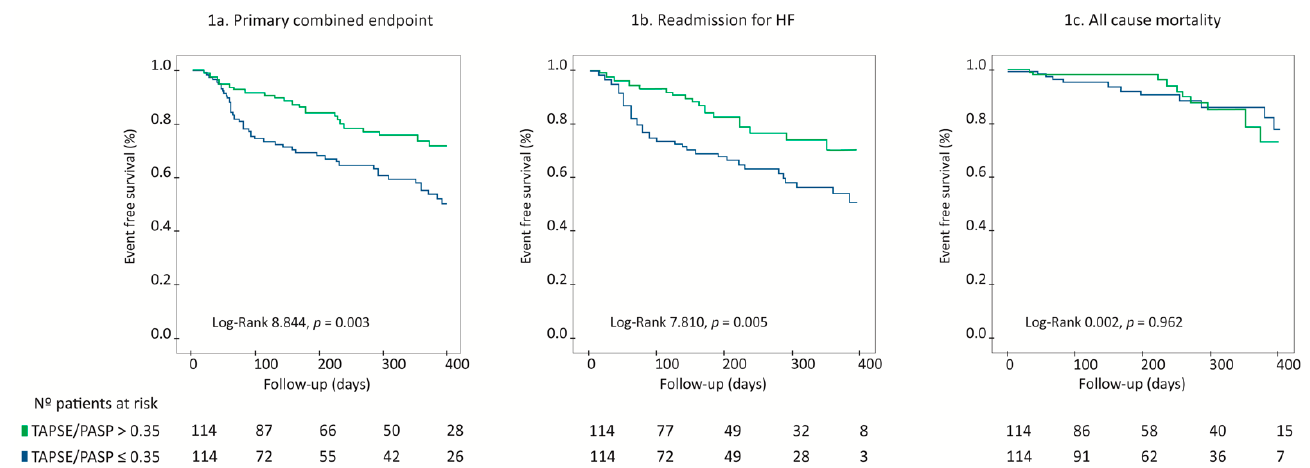
Figure 1. Survival analysis according to TAPSE/PASP ratio as shown by Kaplan–Meier curves. TAPSE/PASP ratio ≤ 0.35 is associated with higher rates of the primary combined endpoint ( a ), higher HF readmissions rates ( b ) without differences in all-cause mortality rates ( c ). TAPSE: tricuspid annular plane systolic excursion. PASP: pulmonary artery systolic pres- sure.